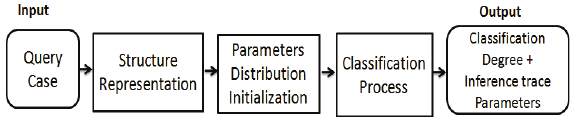
Fig. 3. Classification based Bayesian networks process